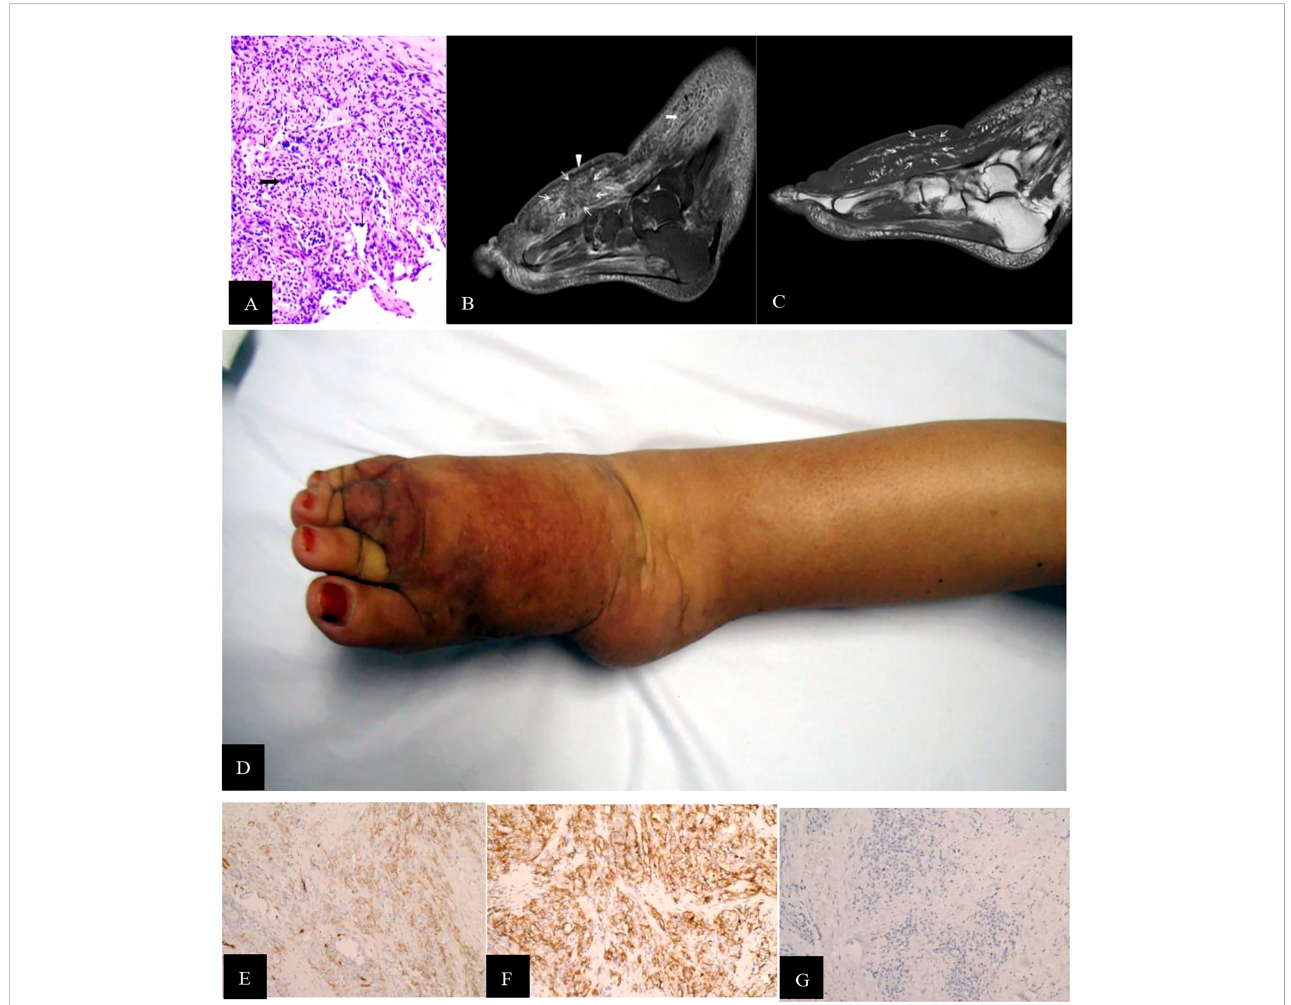
FIGURE 2 (A) STS PLE II type (histopathology, M200). Atypical epithelioid present as slit-like anastomosing spaces ( fi ne black arrowhead) and are composed of loose spindle-type epithelioid cells (wide black arrowhead). There is a lack of vessels. The dysplastic collagen fi bers show a scattered distribution. The underlying muscle had a normal signal intensity. (B) Sagittal T2WI was intermediately and heterogeneously decreased and scattered, revealing a patch- shape in the lymphedema ( fi ne white arrowhead). If compared with the normal muscle tissues, the signal was slightly increased heterogeneously without any recognizable lymphedema signs. One of the regular signs of lymphedema, a Honeycomb sign, presented in the front subcutaneous tissue (wide white arrowhead). (C) Corresponding T1WI signal of STS was slightly decreased compared with the normal muscle ( fi ne white arrowhead). (D) The dorsal skin and subcutaneous soft tissue of the right foot, which showed dark-red spots, increased skin temperature, and non-ulcer. (E, F) CD31 and CD34staining were positive (magni fi catin, x200). (G) D2-40 staining was partially positive (magni fi cation, x200).